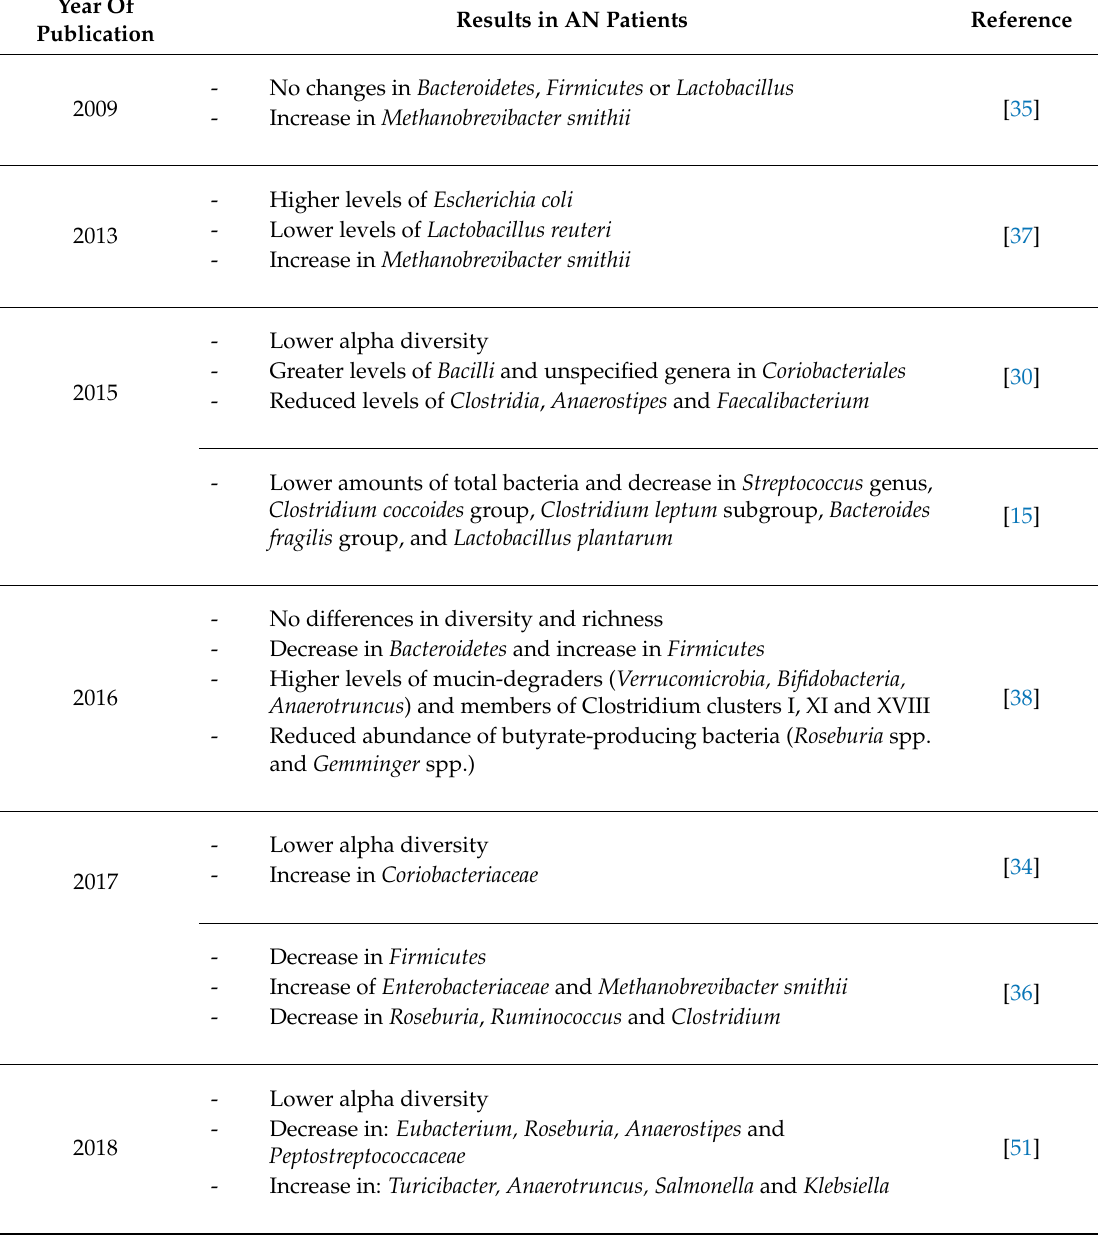
Table 1. Differences of gut microbiota when comparing AN patients and